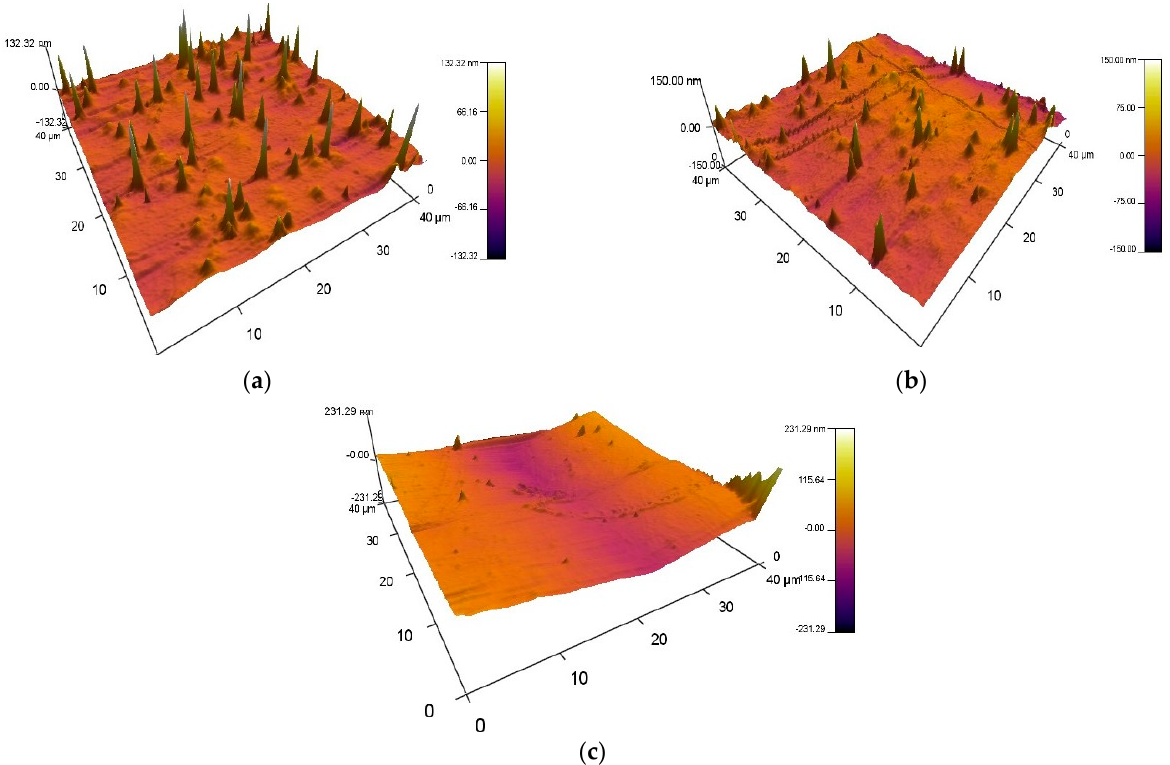
Figure 4. AFM 3D study of the surface topography of the different coatings grown on PEN substrate: BST film ( a ); BST film of PVDF-TrFE-coated PEN ( b ) and PVDF-TrFE film on BST/PVDF-TrFE/PEN ( c ).